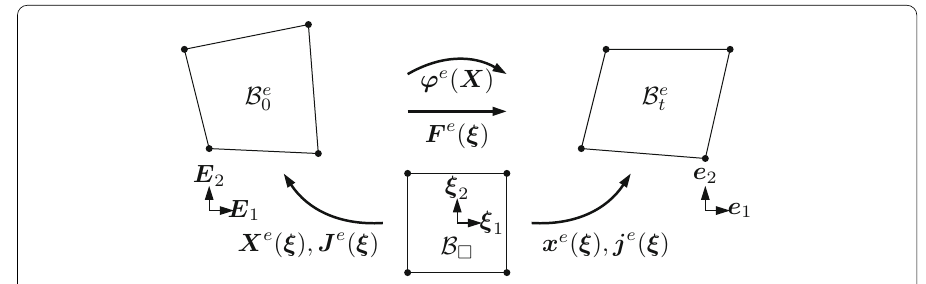
and the spatial element B e 0